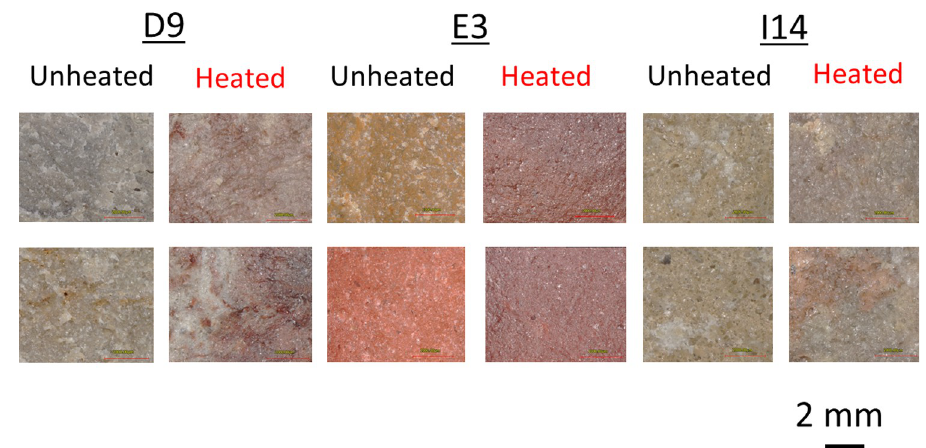
Fig 1. Color and roughness change. Microphotographs of representative silcrete samples from the three silcrete sources used in this study showing variation in color and surface roughness before and after heat treatment.